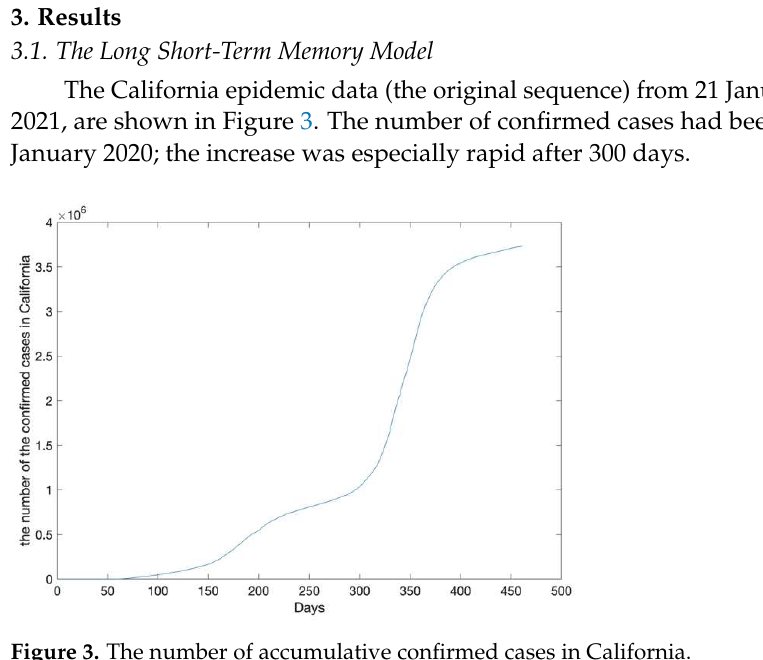
Figure 3. The number of accumulative confirmed cases in